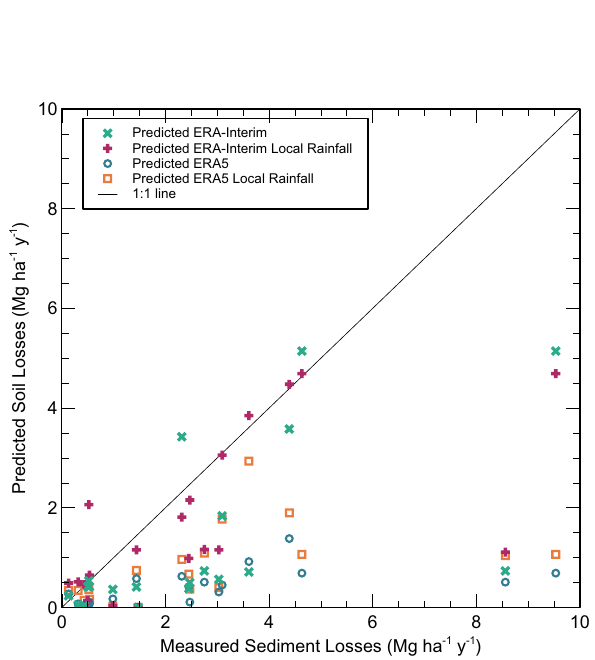
Predicted ERA-Interim Predicted ERA-Interim Local Rainfall Predicted ERA5 Predicted ERA5 Local Rainfall 1:1 line